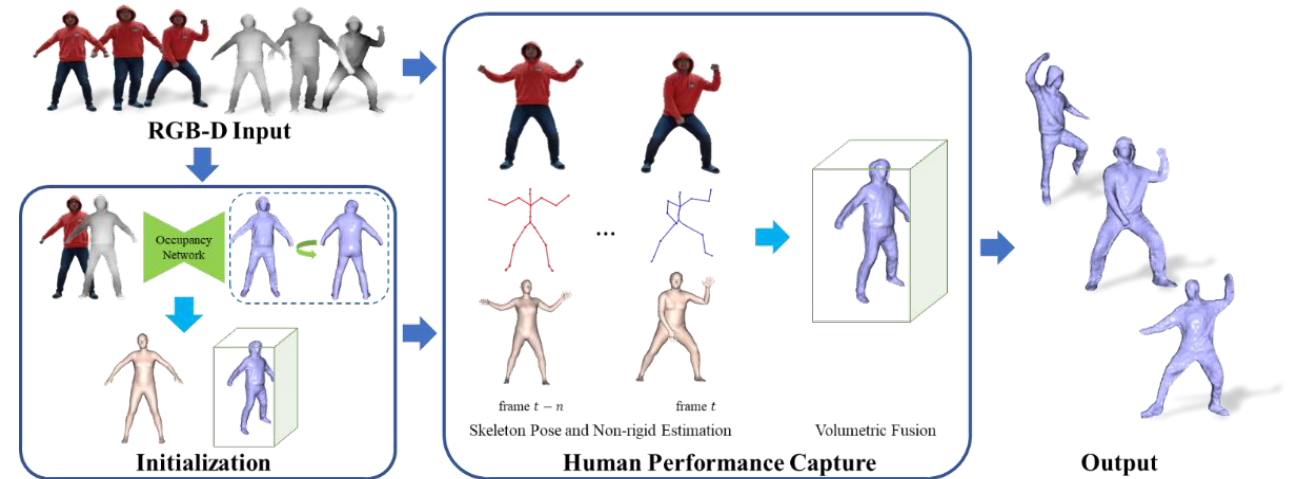
Figure 1. The pipeline of our method.